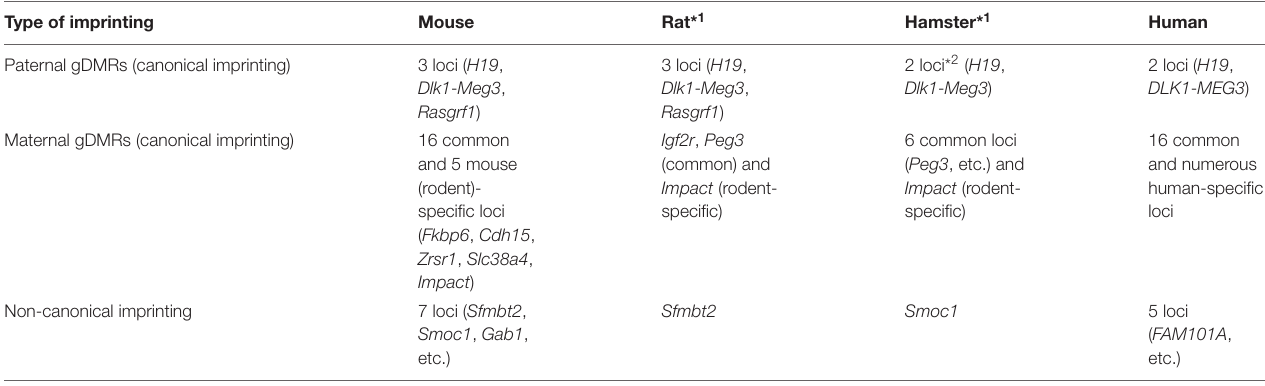
TABLE 1 | List of identified canonically and non-canonically imprinted regions. Type of imprinting Mouse Rat* 1 Paternal gDMRs (canonical